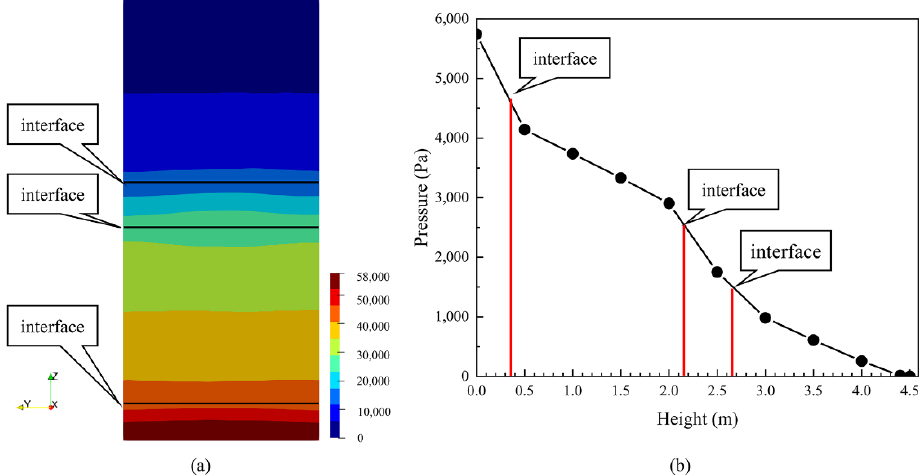
Figure 10. The pressure distribution of the 2-layer material column: ( a ) pressure distribution profile and ( b ) pressure versus height graph.